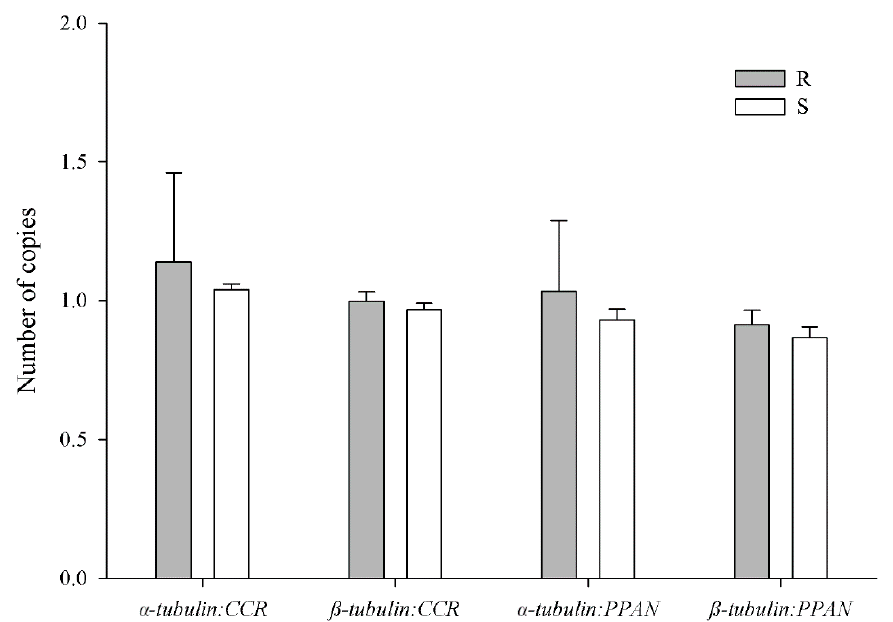
Figure 5. Gene copy number estimation of the α and β - tubulin genes relative to CCR and PPAN reference genes in trifluralin-resistant (R) and susceptible (S) accessions. Bars ± standard deviation of the mean ( n = 4). A Student’s t -test analysis was performed to assess significant differences (denoted by an *) between accessions.